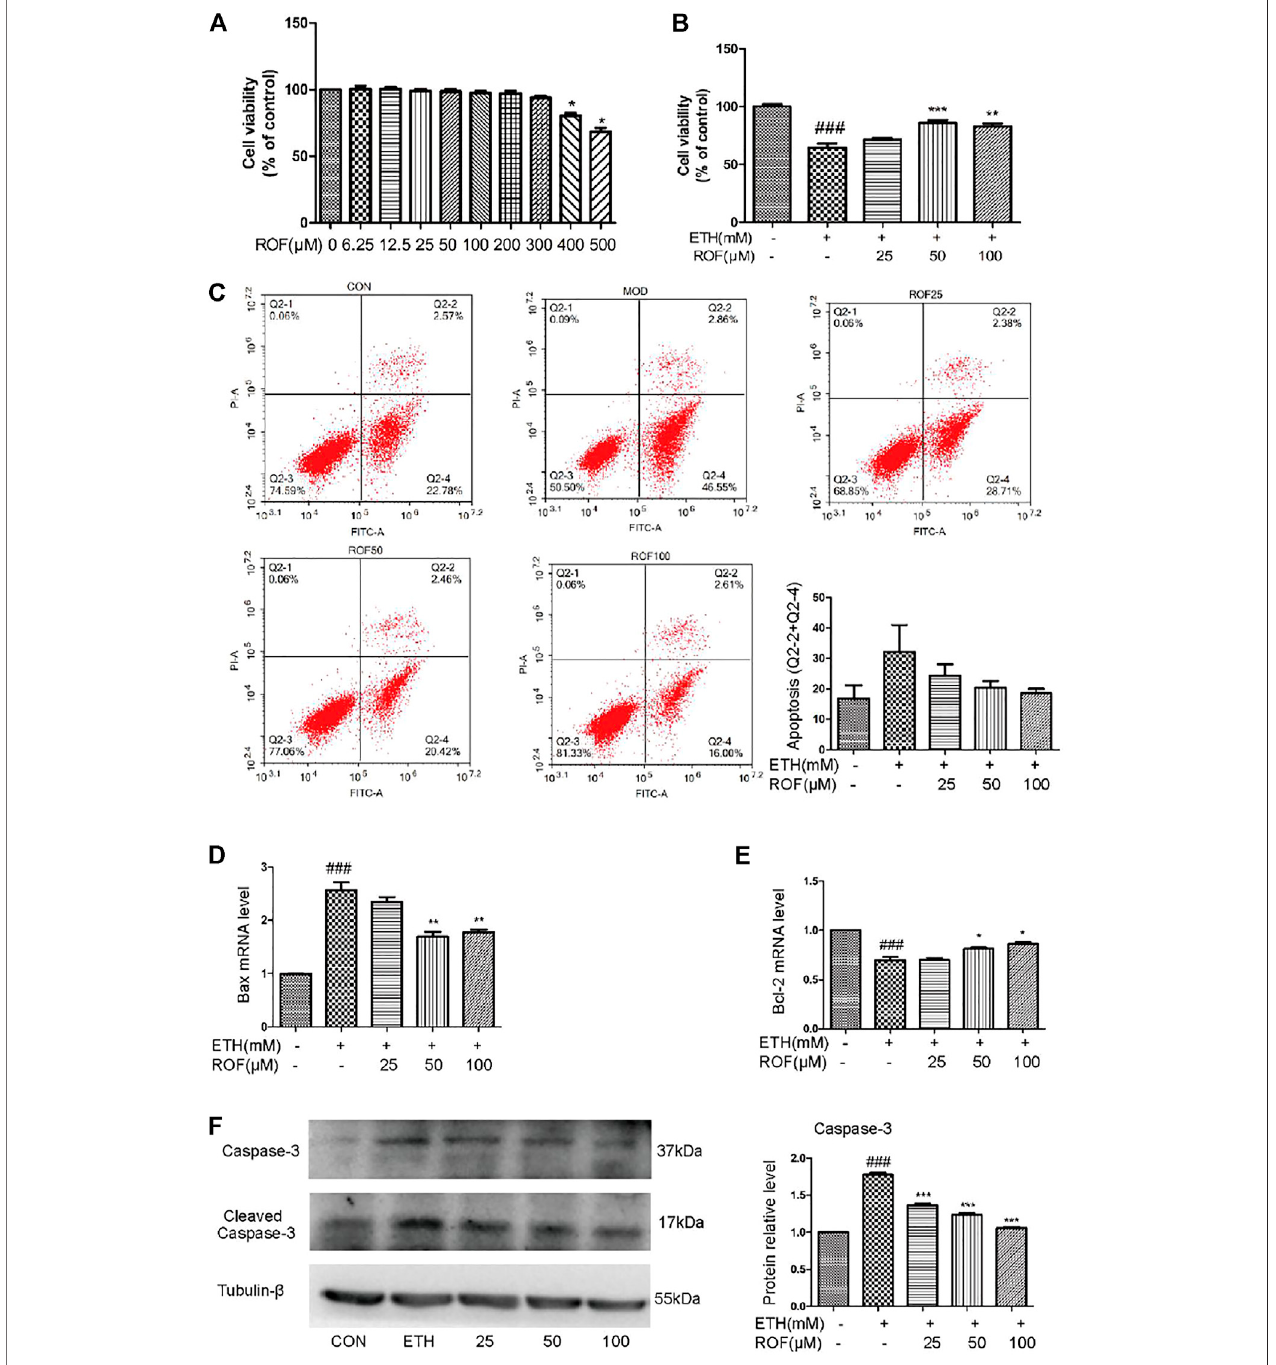
FIGURE 4 | Effects of ROF on cell apoptosis and viability: (A , B) Cell viability of ETH (200 mm) and ETH + ROF groups after treatment for 24 h. The apoptotic rate (C) , Bax expression (D) , and Bcl-2 expression (E) in LO2 cells. The protein levels of caspase 3 and cleaved caspase 3 (F) . Mean ± SEM ( n = 3 – 6). * p < 0.05, ** p < 0.01 and *** p < 0.001 vs. the ETH group. ### p < 0.001 vs. the CON group.